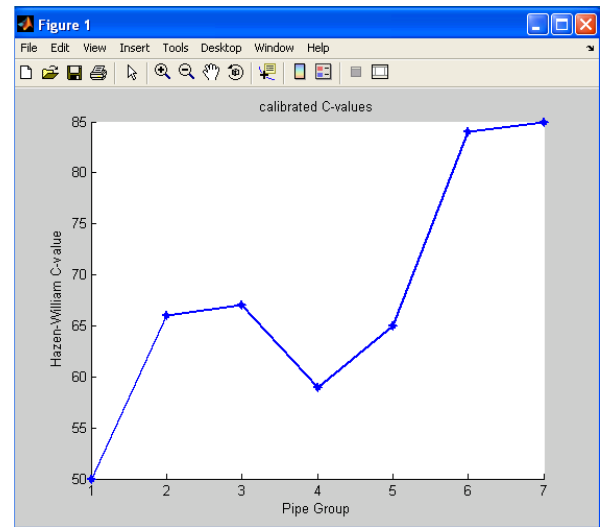
Fig. 13. Calibration result for Vasant Vihar WDN